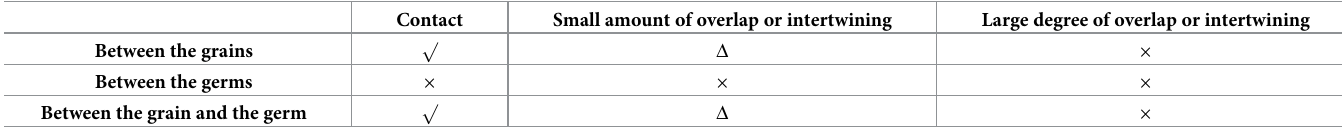
p Table 3. The effects of contact or overlap between grains or germs on germination rate, where ’ ’ means allowed and has no effect on germination rate, ’ × ’ means prohibited and has an effect on germination rate, ’ 4 ’ means partially allowed and may have an effect on germination rate. Contact Small amount of overlap or intertwining Large degree of overlap or intertwining p Between the grains Δ × Between the germs × × × p Between the grain and the germ Δ